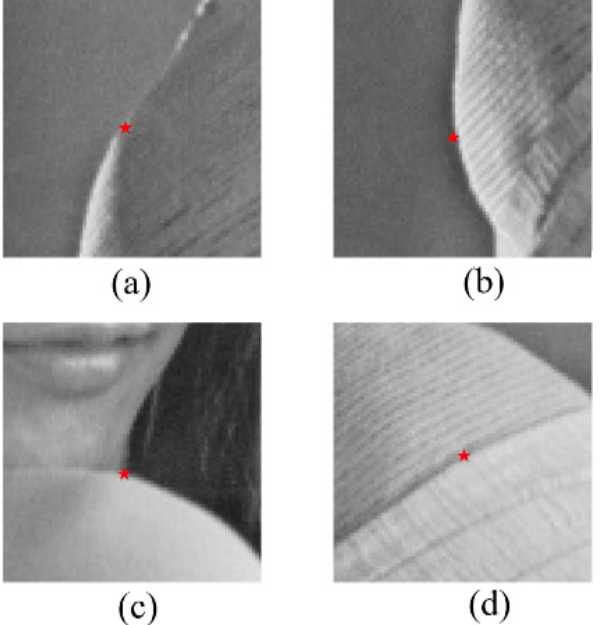
Figure 6. Determination of edge direction: ( a ) − 45° edge direction; ( b ) horizontal edge direction; ( c ) vertical edge direction; ( d ) − 45° edge direction.